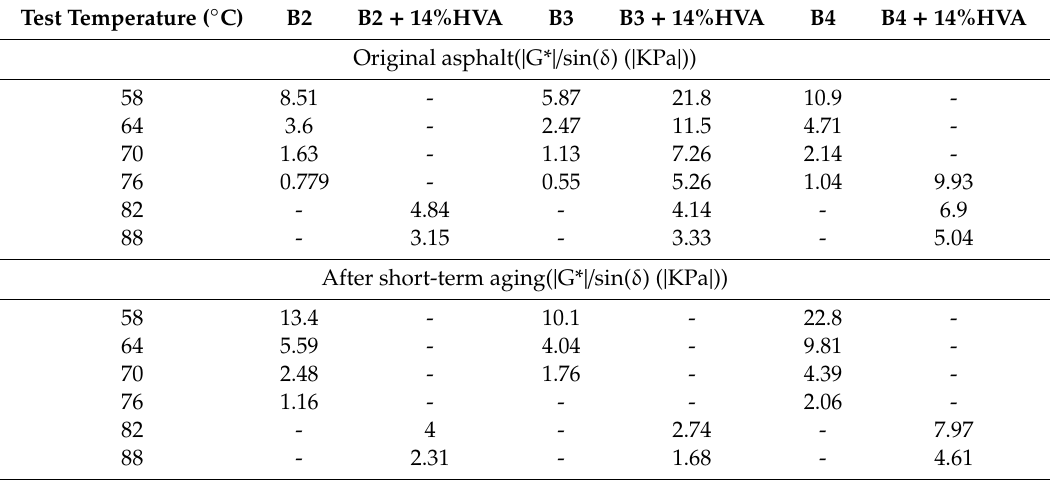
Table 3. Test results of high temperature performance